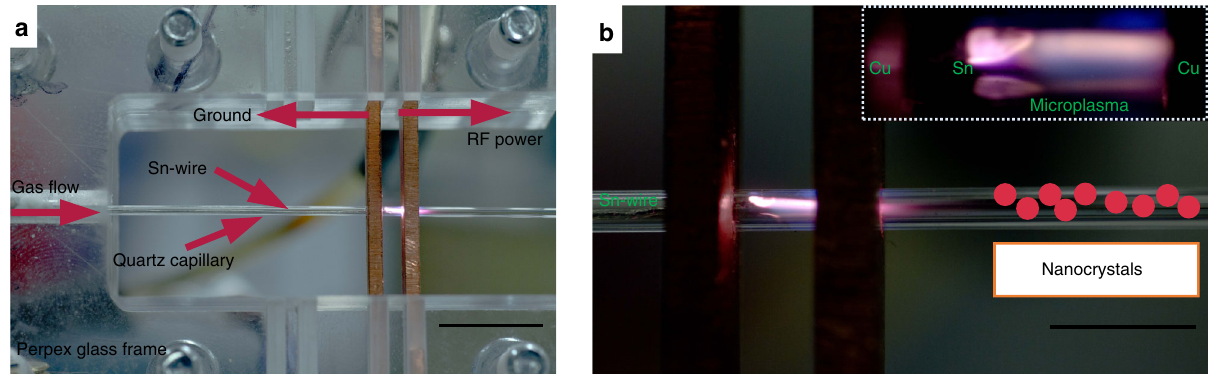
Fig. 1 Microplasma reactor con fi guration at atmospheric pressure. a A photographic illustration of the plasma reactor set up. A tin wire (0.25 mm diameter) is placed inside the capillary such that one end of the wire is connected to ground and the other end is suspended at the middle position between the two copper electrodes; b A high-resolution photograph of the plasma region where the Sn-wire is clearly seen (also shown in the inset image). The scale bars in ( a ) and ( b ) are 5 and 4 mm respectively